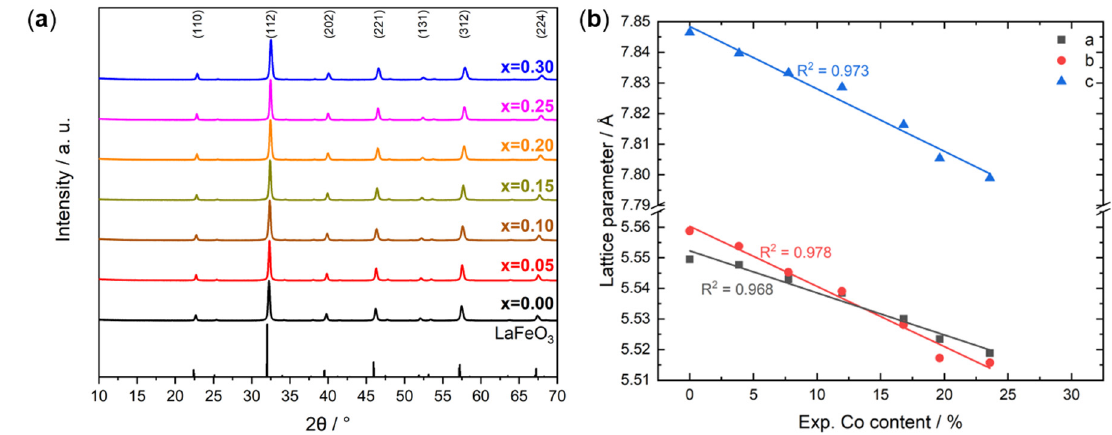
Figure 3. ( a ) XRD powder patterns of the samples after calcination. ( b ) Lattice parameters of the samples from Rietveld refinement plotted against the experimental Co content.